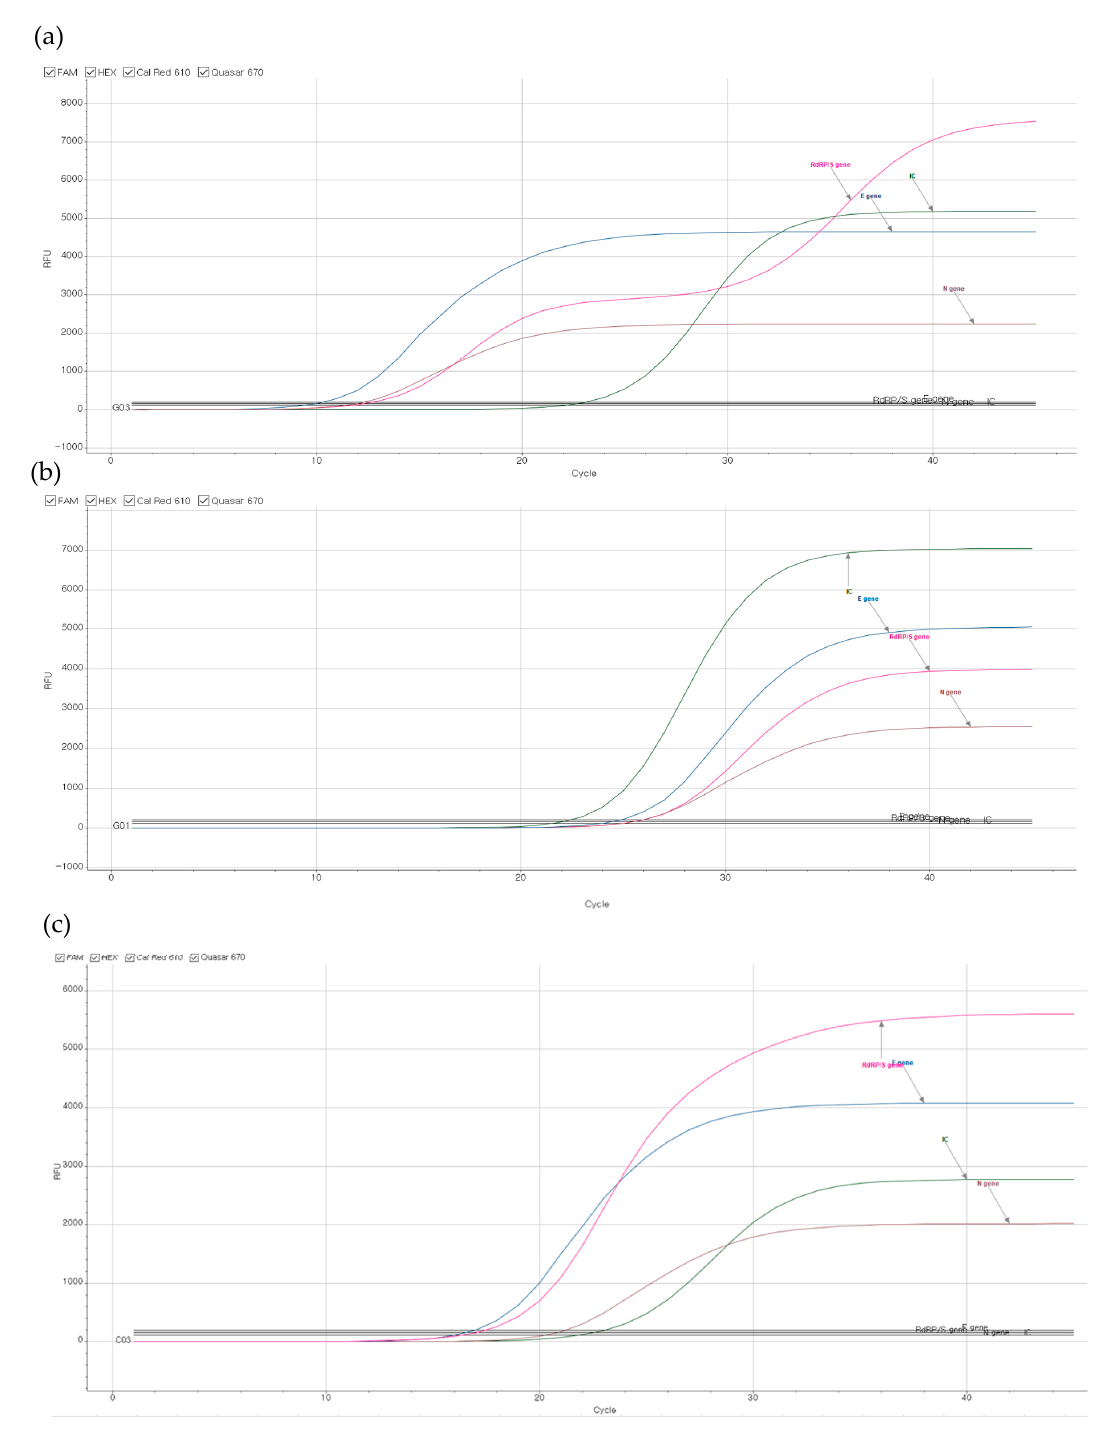
Figure 1. Representative RT-PCR amplification curve results; ( a , b ) COVID-19 positive samples revealed with delta variant with ( a ) a double curve pattern of RdRp/S, or ( b ) a single curve pattern and lower fluorescence units of RdRp/S than E gene and N gene. ( c ) COVID-19 positive samples with no specific variant: RdRp/S curve shows single amplification pattern with higher fluorescence units than E gene. Pink color: RdRp/S gene, blue color: E gene, brown color: N gene, green color: internal control.